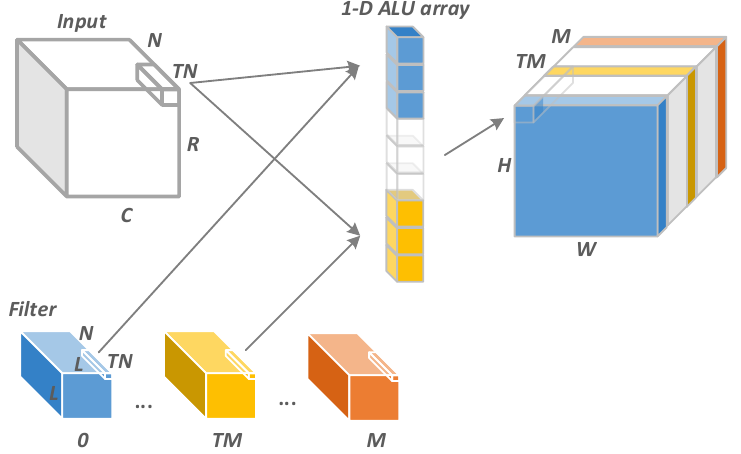
Figure 3. Convolution parallelization along input channel and filter batch dimension on a 1-D MAC